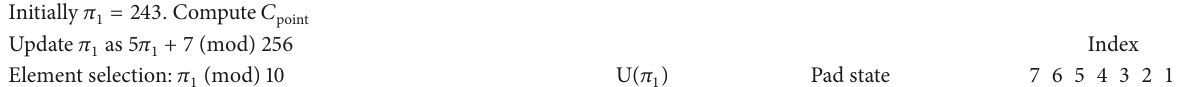
Table 5: Working of the IGRKG method (U: updated, SPE: selected pad